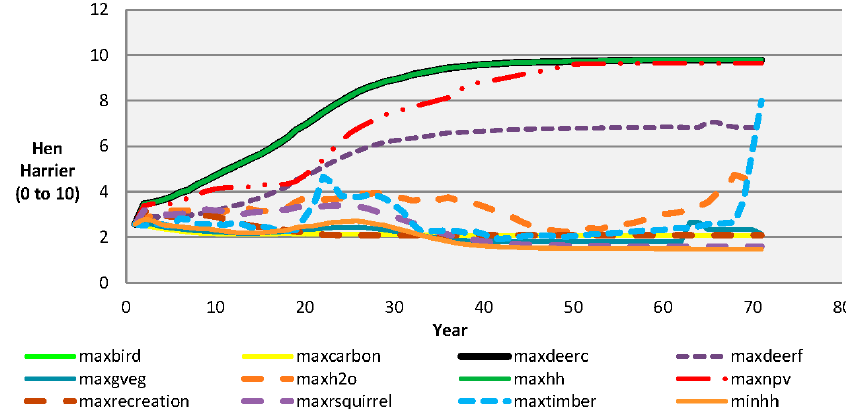
Figure 4. Hen harrier biophysical range and trade-off when maximising other ESs over the planning period in the Western Peatland case study area.